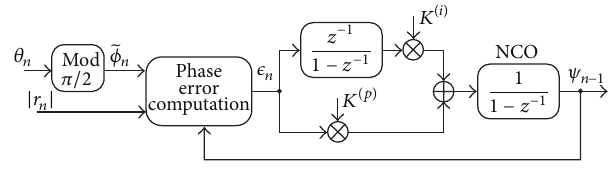
Figure 8: Phase domain digital